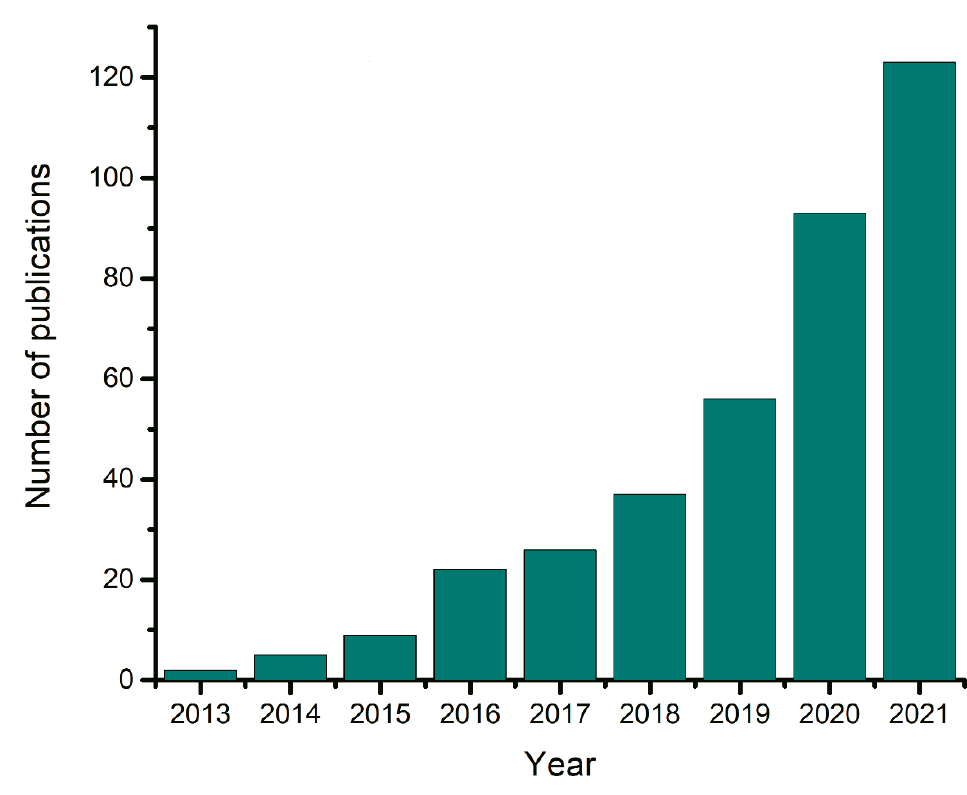
Figure 1. Number of publications per year with keywords “DESs + simulation” in the Web of Science.